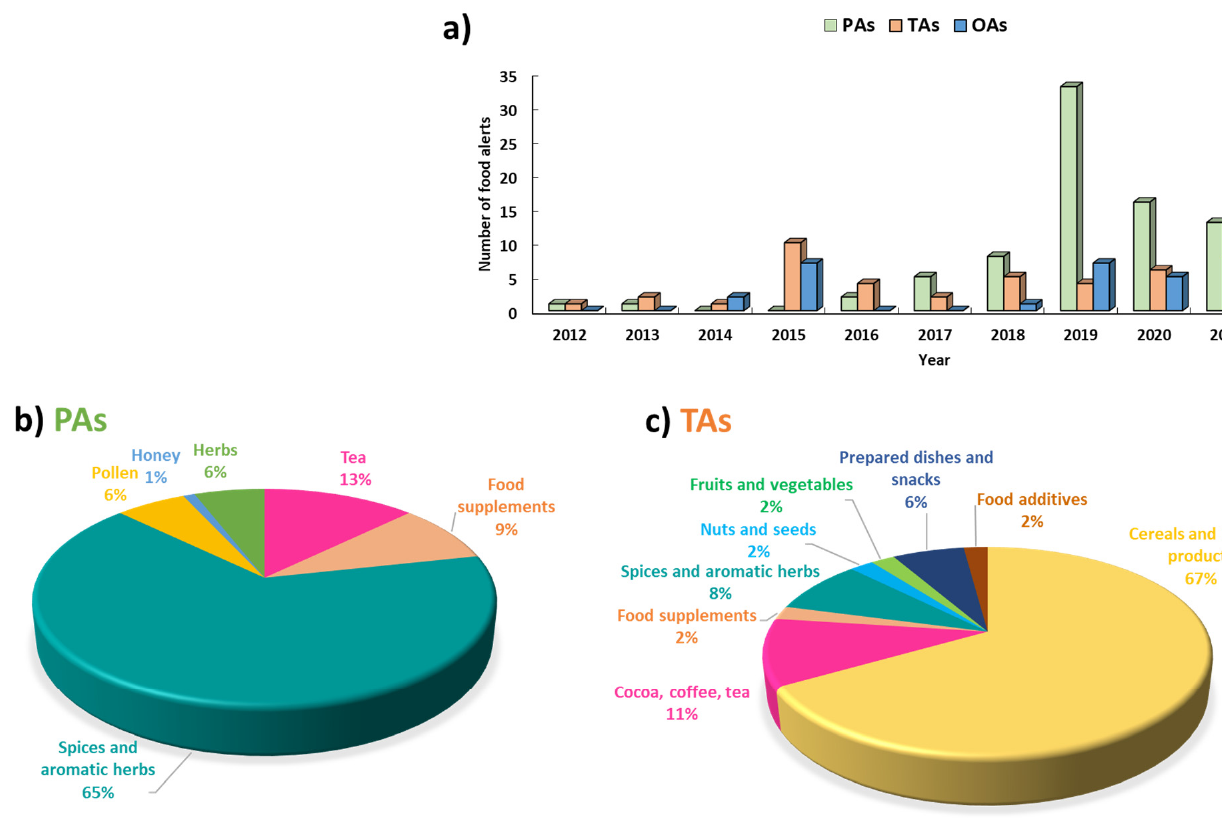
Commented [M1]: The numbers in the pie chart of Figure 1, add up to over 100%, please revise it. Commented [NCN2R1]: It has been corrected. Please, aligned the figure caption to the left.